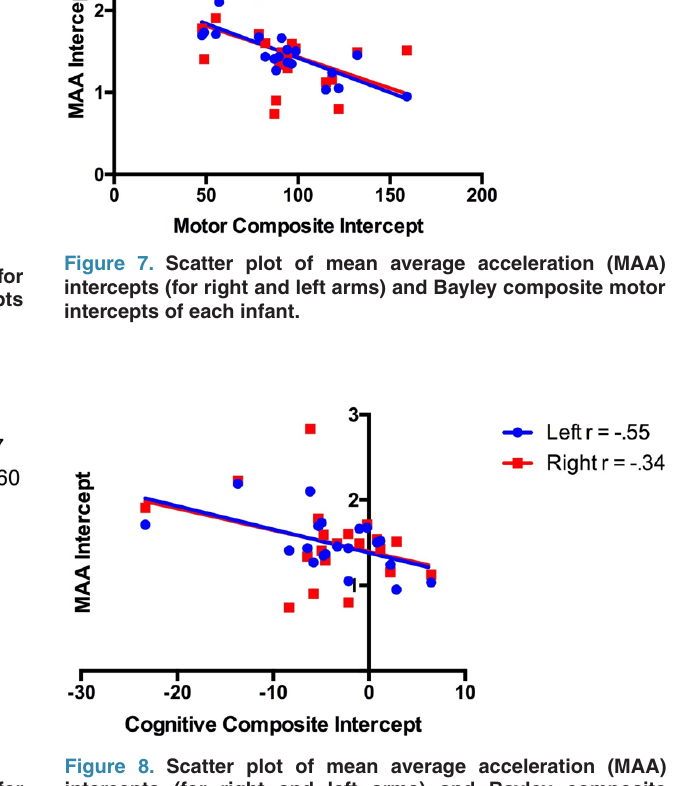
Figure 5. Scatter plot of bouts per awake time intercepts (for right and left arms) and Bayley composite language slopes of each infant.